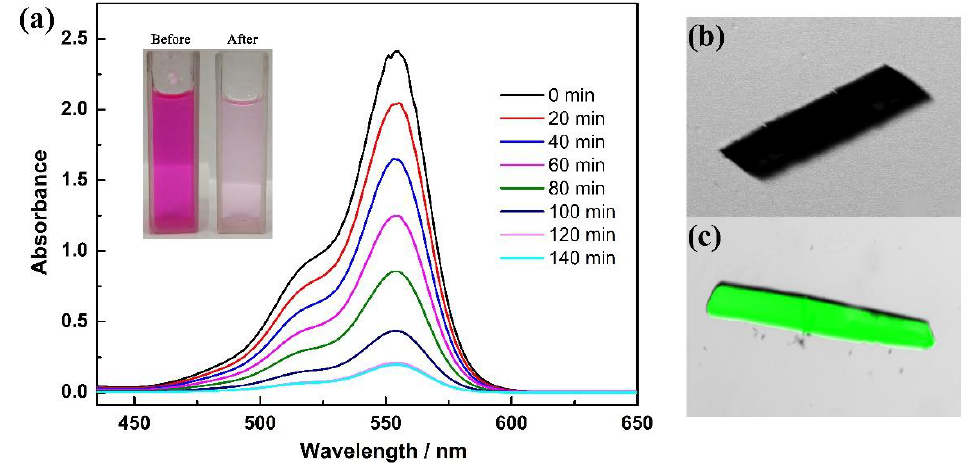
Figure 5. ( a ) UV-vis spectra of RhB after immersing 1 at different time intervals. Insert: The pictures of RhB solution before and after adsorption by 1 ; Confocal images of empty ( b ) and soaked ( c ) RhB dye molecule of 1 .